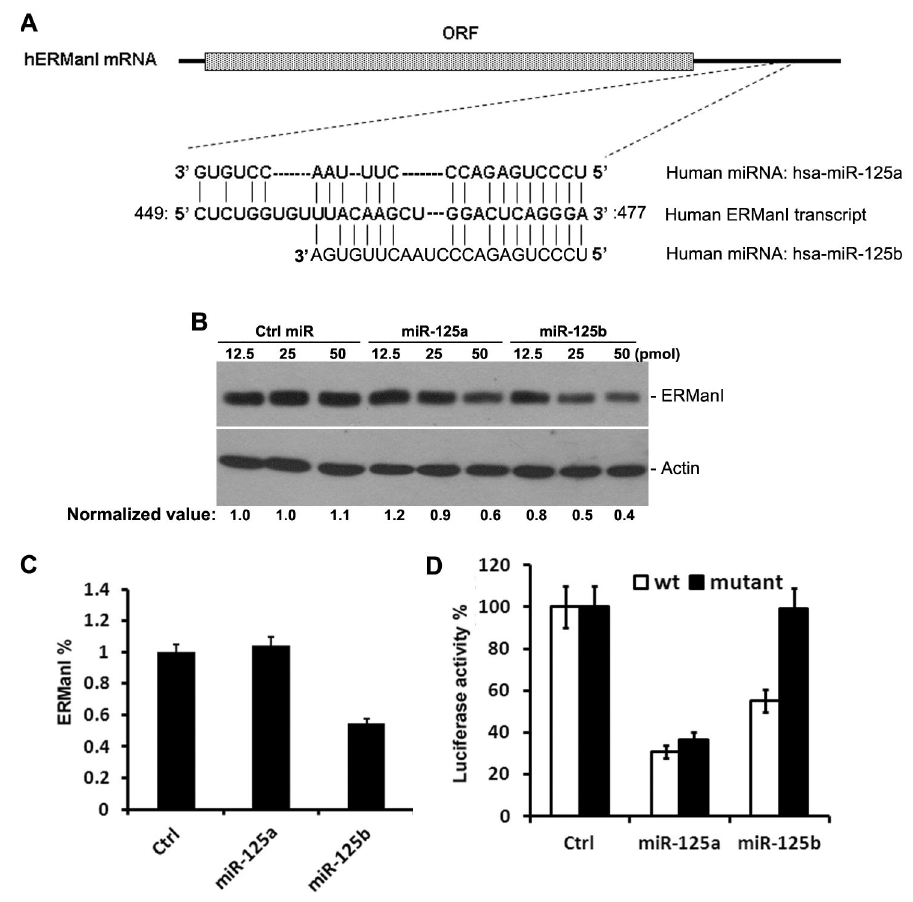
Figure 1. ERManI is a target of miR-125b. A . Illustration of the predicted target sequence of miR-125a and miR-125b located at the 3’-UTR of ERManI mRNA. “CUCAGGGA” on ERManI transcript represents the seed sequence. B . Western blotting of ERManI and actin (used as loading control) in PLC/PRF5 cells transfected with indicated amounts of control miRNA, miR-125a, or miR-125b. C . The percentage of ERManI expressed in MCF7 cells transfected with 12.5pmol miR-125a or miR-125b as compared to that transfected with equal amounts of control miRNA. The data were based on the densitometry measurement of the protein bands detected by western blotting. Error bars represent one standard deviation from three repeated samples. D . The luciferase constructs carrying the wild-type 3’UTR of ERManI or the ERManI 3’UTR with a mutated seed region were transfected into HeLa cells, and the luciferase activities were measured 24hr after transfection. The average activities from three repeated samples were used to calculate the percentage of inhibition. Error bars represent the standard error of the mean from three independent